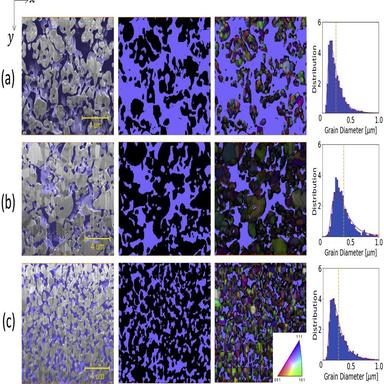
Aanalyzed SEM/EBSD data. Left: SEM grey value data of a representative 2D slice and projected segmented pore phase (blue). Copper phase in original grey value. Middle: segmented copper (black) and pore phase (blue). Right: projected segmented pore phase on the SEM/EBSD (IPF-IQ) data. (a) Sample A, (b) sample B and (c) sample C with the corresponding grain size distribution (dashed lines show the corresponding means) obtained from the image processed SEM/EBSD data. Red line indicates the log-normal fit. The